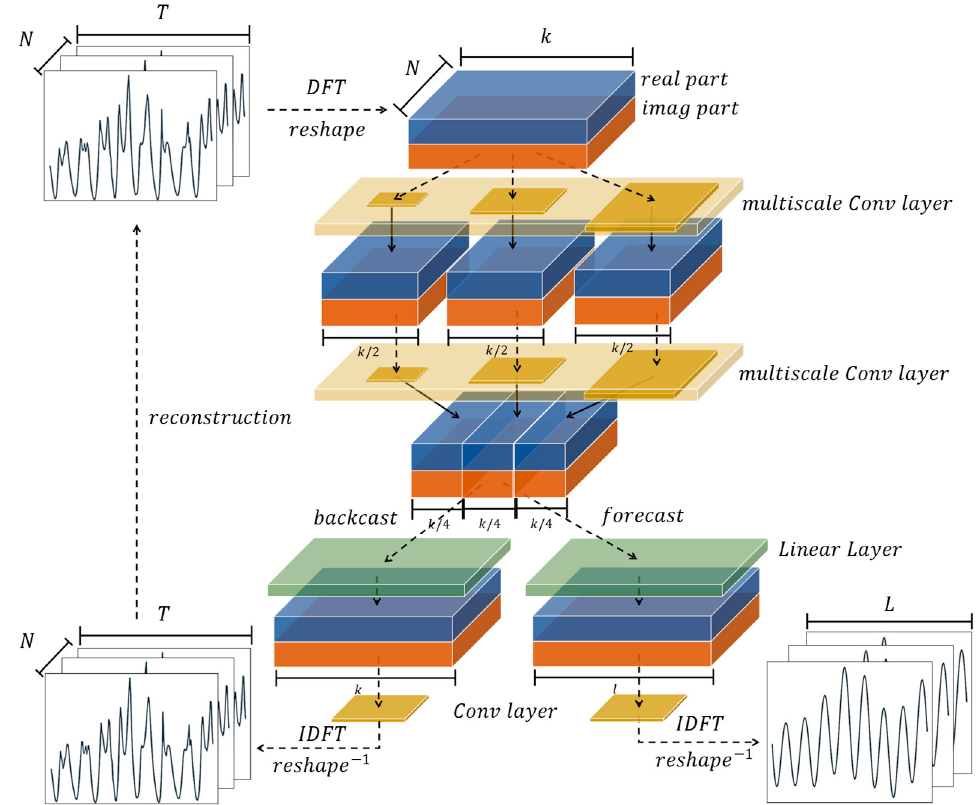
Figure 3 . Multiscale backcast convolution neural network structure. Figure 3. Multiscale backcast convolution neural network